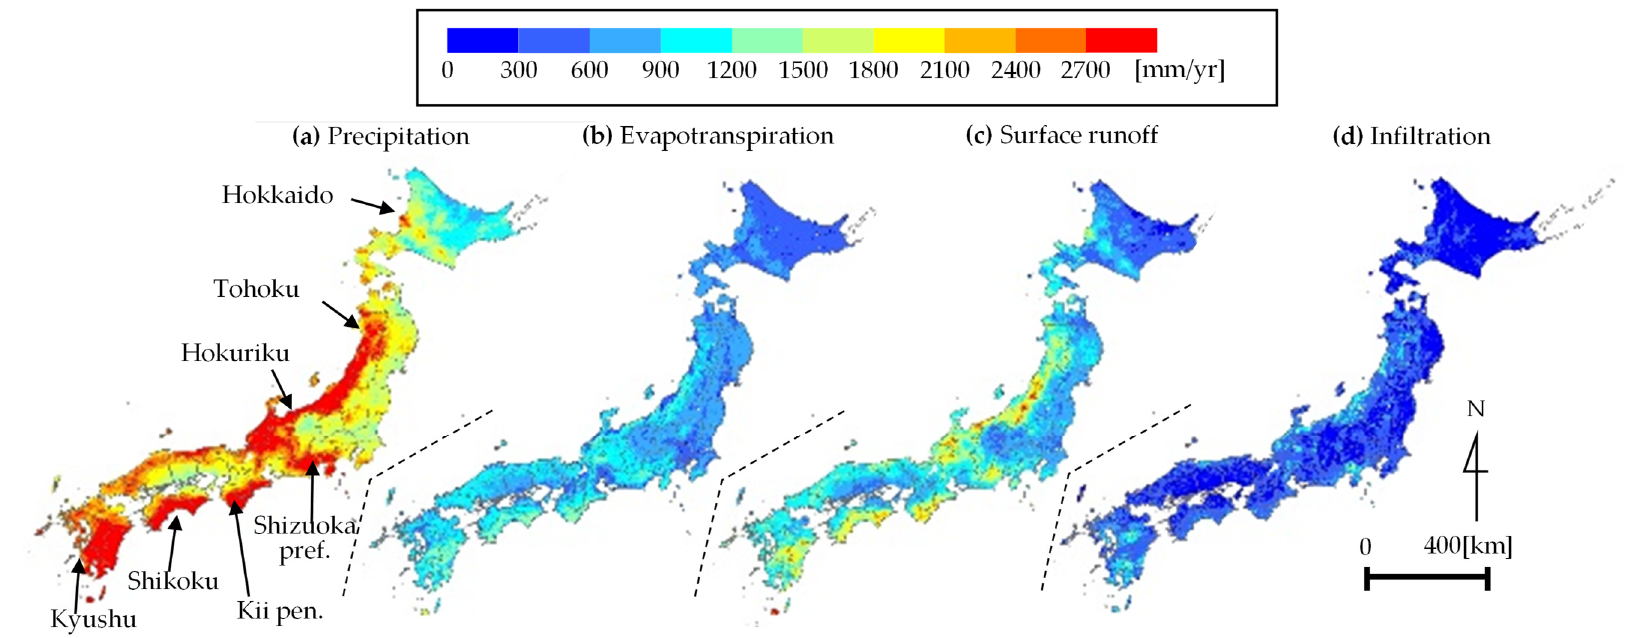
Figure A1. Annual precipitation ( a ), evapotranspiration ( b ), surface runoff ( c ), and underground infiltration ( d ) obtained from the water-balance analysis.